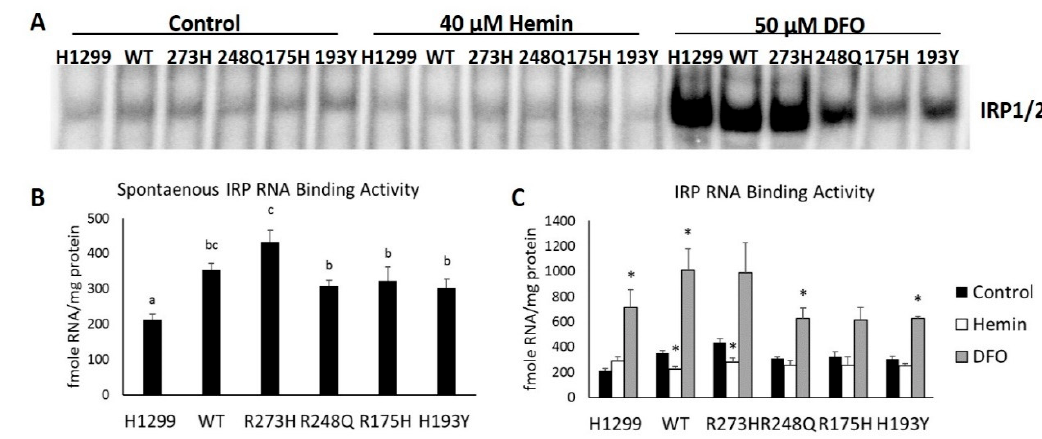
Figure 4. TP53-dependent responsiveness of IRP RNA binding activity following under normal, high, and low iron conditions. Spontaneous IRP RNA binding was assayed following tetracycline induction of WT or the indicated TP53 mutants under control conditions ( A , B ) or following treatment with 40 μ M hemin or 50 μ M desferrioxamine (DFO) for 48 h ( A , C ). Superscripts (a,b,c) denote statistical difference between mutation types. * Denotes statistical difference from respective controls, p < 0.05.